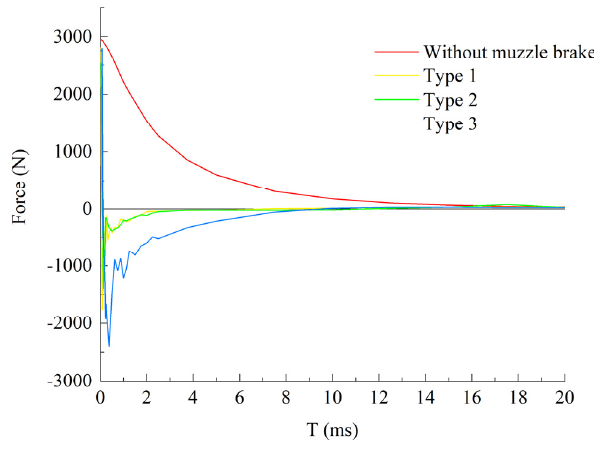
Figure 22. Force varying with time of three different muzzle brakes. Table 5. Comparison of muzzle brake efficiency and comprehensive noise performance.